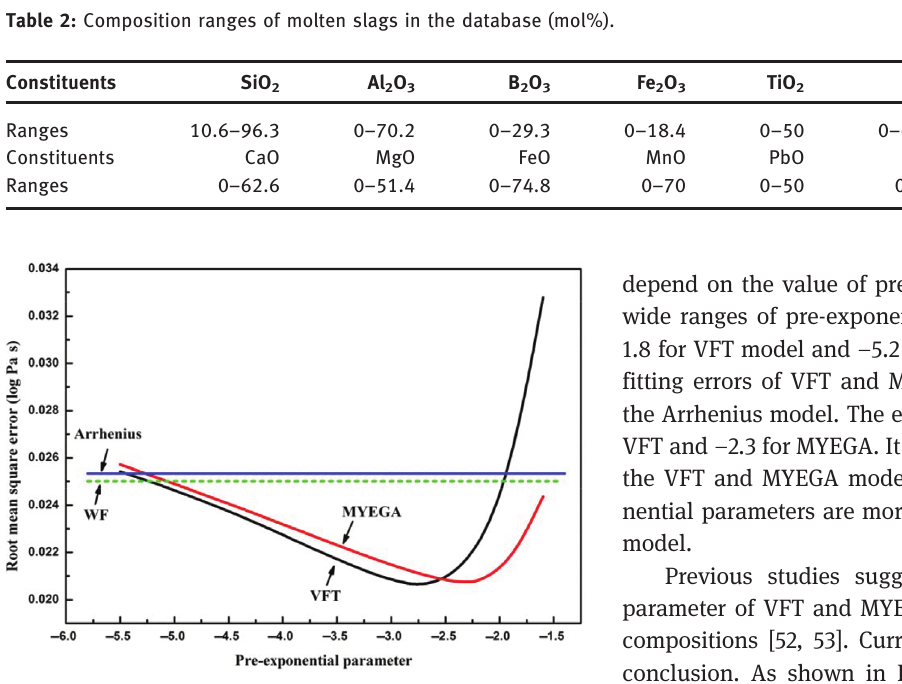
Figure 2: Molten slag viscosity fitting errors of Arrhenius, WF models and VFT and MYEGA models with constant pre-exponential parameter.